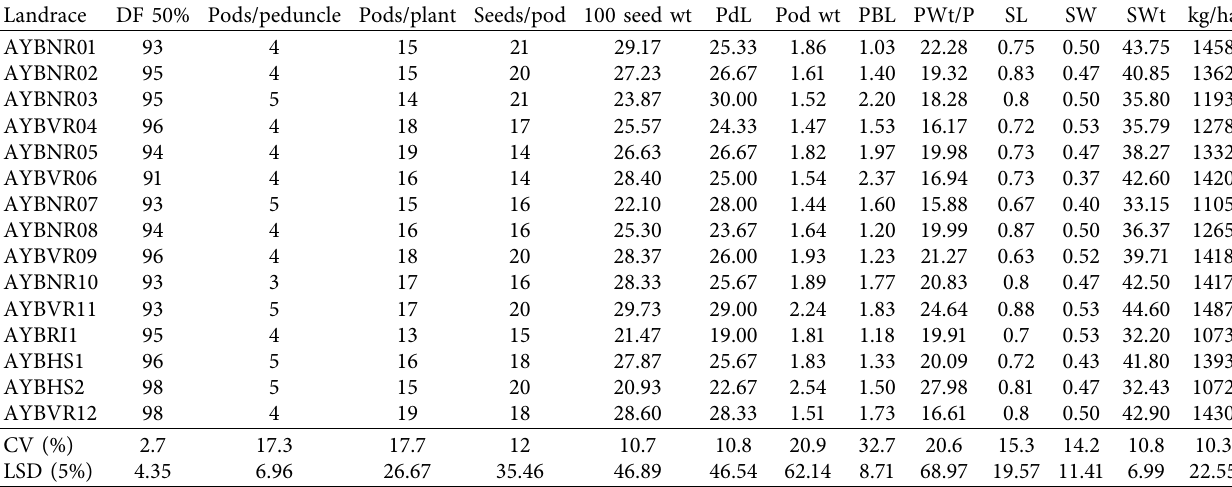
Table 4: Te mean performances of the yield and yield traits of the landraces.